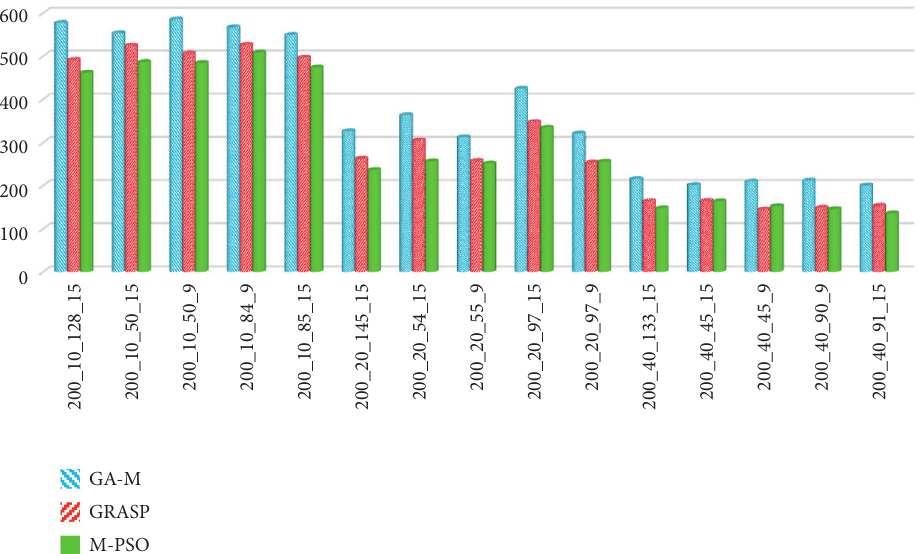
Figure 6: Comparing BEST values between GA-M, GRASP, and M-PSO of 200 tasks projects.